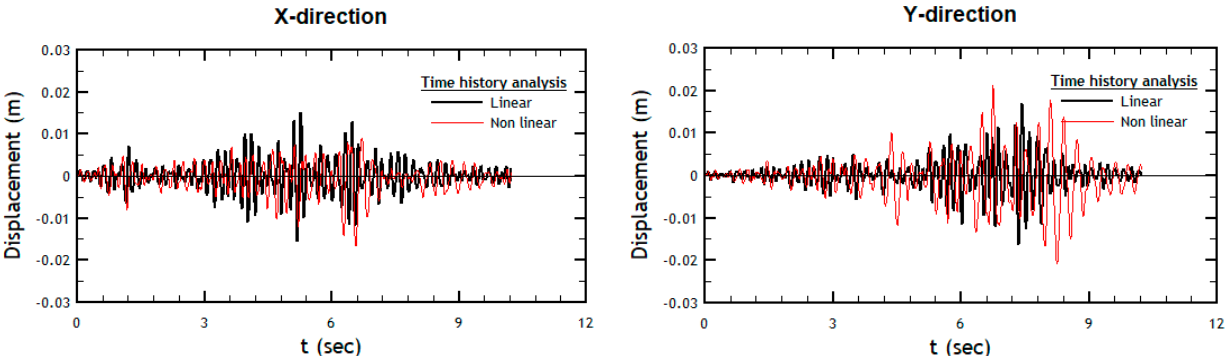
Figure 18. Interstory drifts obtained from the different types of analyses. ASCE-SEI 41-17 (red dashed vertical lines) and ACHISINA limits (purple dash-dot vertical lines) are also plotted.